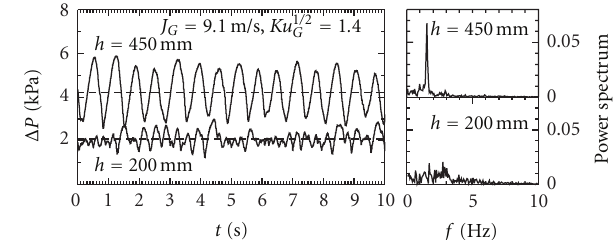
Figure 13: Pressure di ff erence Δ P between upper and lower tanks (Cylindrical tank (b), D = 30mm, V Lower = 0.092 m 3 and J G = 9 .